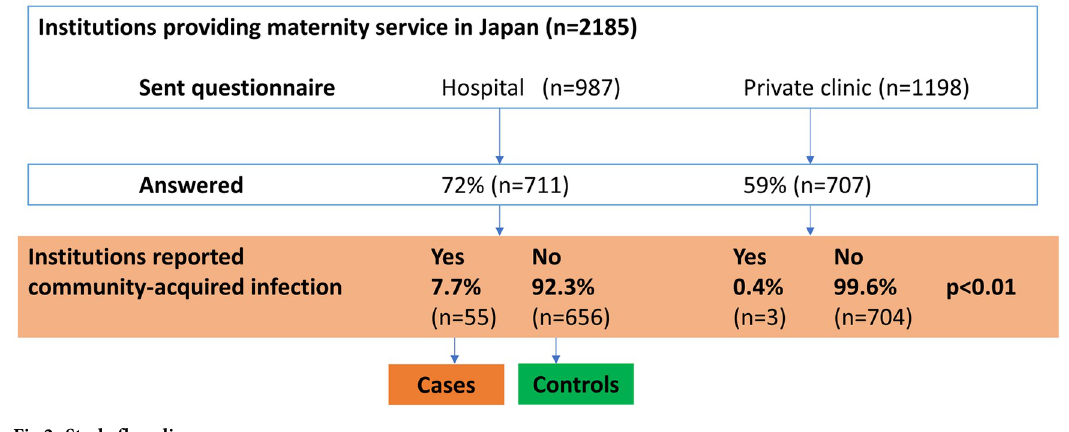
Fig 2. Study flow